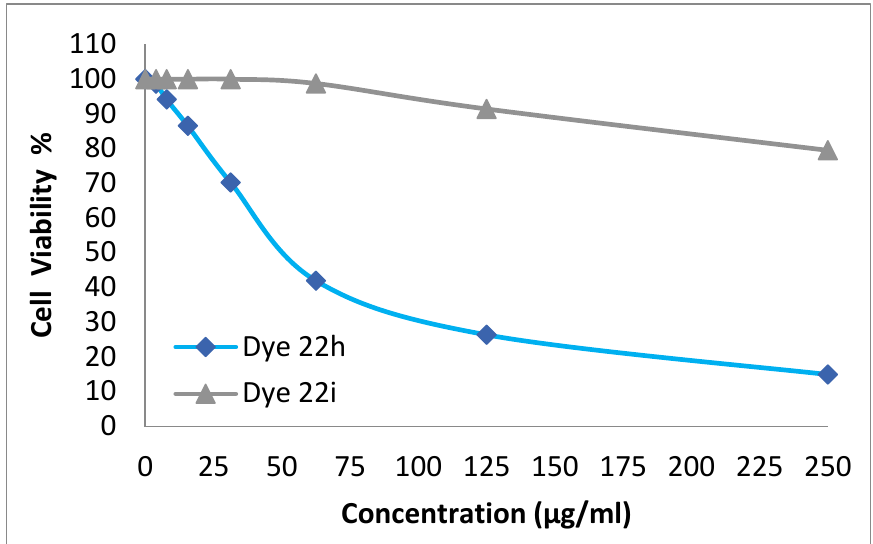
Figure 9. Antitumor (A-549) activities of disperse dyes 22h and 22i.